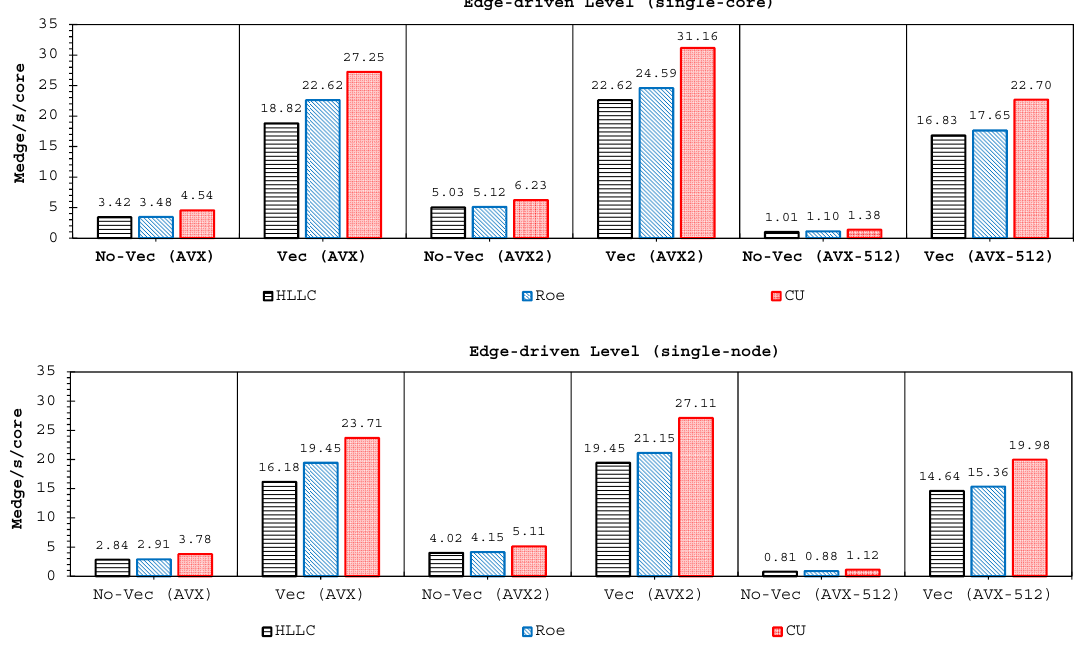
Figure 18. Comparison of performance metrics in the edge-driven